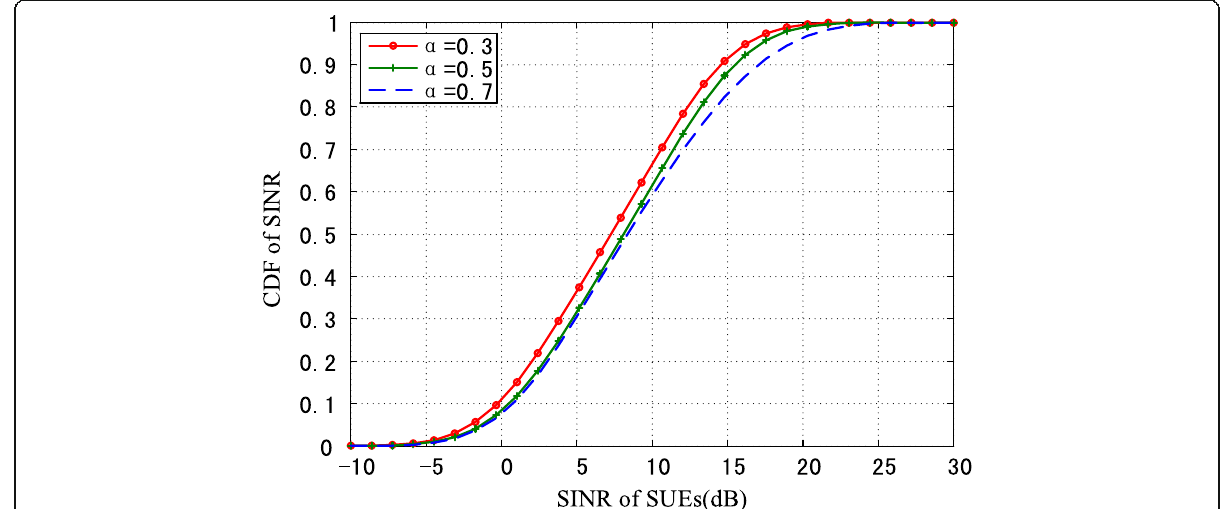
Fig. 4 Comparison of SINR performance with varying factor of α . In Fig. 4 and Fig. 5, we describe the impact of different values of α and β on the network performance. In specific, the values of α and β represent the weight of QoS and power consumption in the system. In Fig. 4, when the value of α is small, the SINR of UEs performs worse due to the lower weight of QoS. It is shown that the satisfaction of UEs improves when the